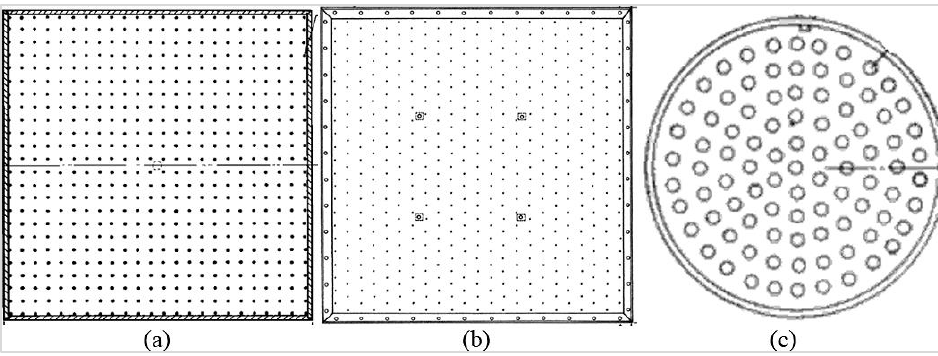
Figure 10. Patterns of drippers arrangement: ( a ) Rectangular [17] (Reprinted/adapted with permis- sion from Ref. [Chow et al., 1965]); ( b ) Triangular [18] (Reprinted/adapted with permission from Ref. [Meeuwig et al., 1971]); ( c ) Circular [28] (Reprinted/adapted with permission from Ref. [Steinhardt & Hillel, 1966]).